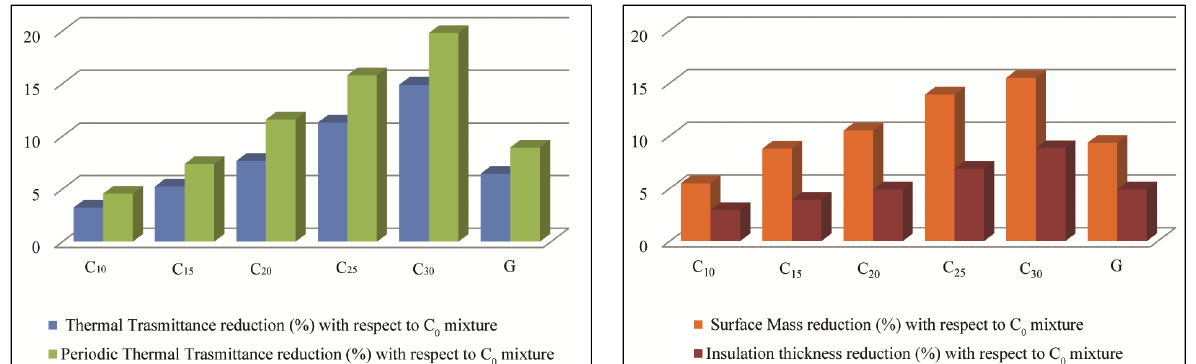
Figure 4. Percentage reductions of the quantities of interest obtainable with the present concrete